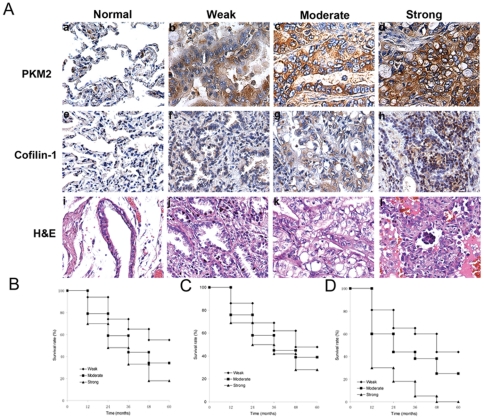
Immunohistochemical (IHC) analysis.(A). IHC staining against PKM2 and cofilin-1. (B). Kaplan-Meier survival curves showed the correlation between higher levels of PKM2 expression and lower survival rates (p<0.05). (C). Kaplan-Meier survival curves showed the correlation between higher levels of cofilin-1 expression and lower survival rates (p<0.05). (D). Kaplan-Meier survival curves showed the combination of PKM2 and cofilin-1 as predictor correlated more closely with prognosis of lung adenocarcinoma (p<0.05).